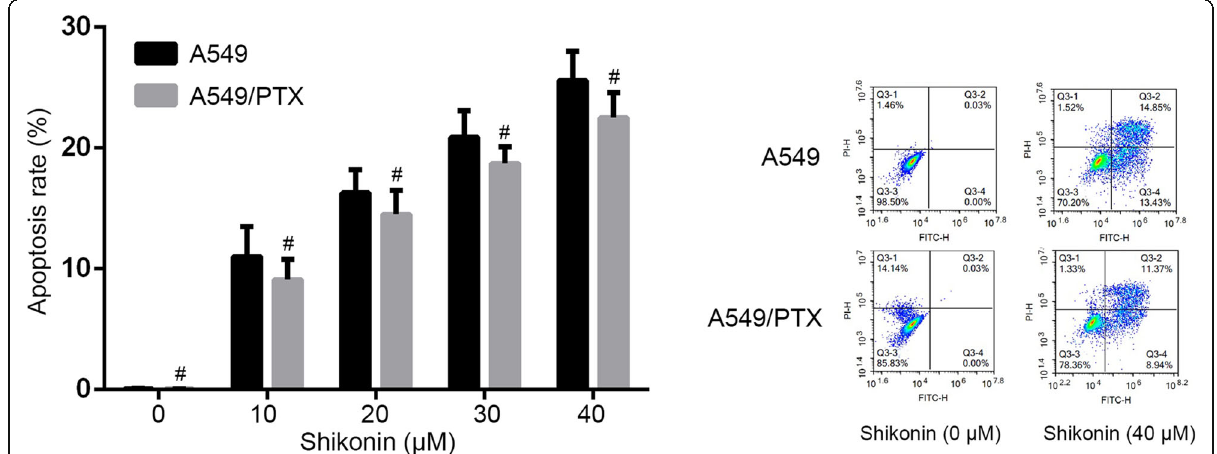
Fig. 2 Shikonin induced apoptotic cell death of paclitaxel-resistant NSCLC cell lines in a dose-dependent manner. #No statistically significant difference( p >